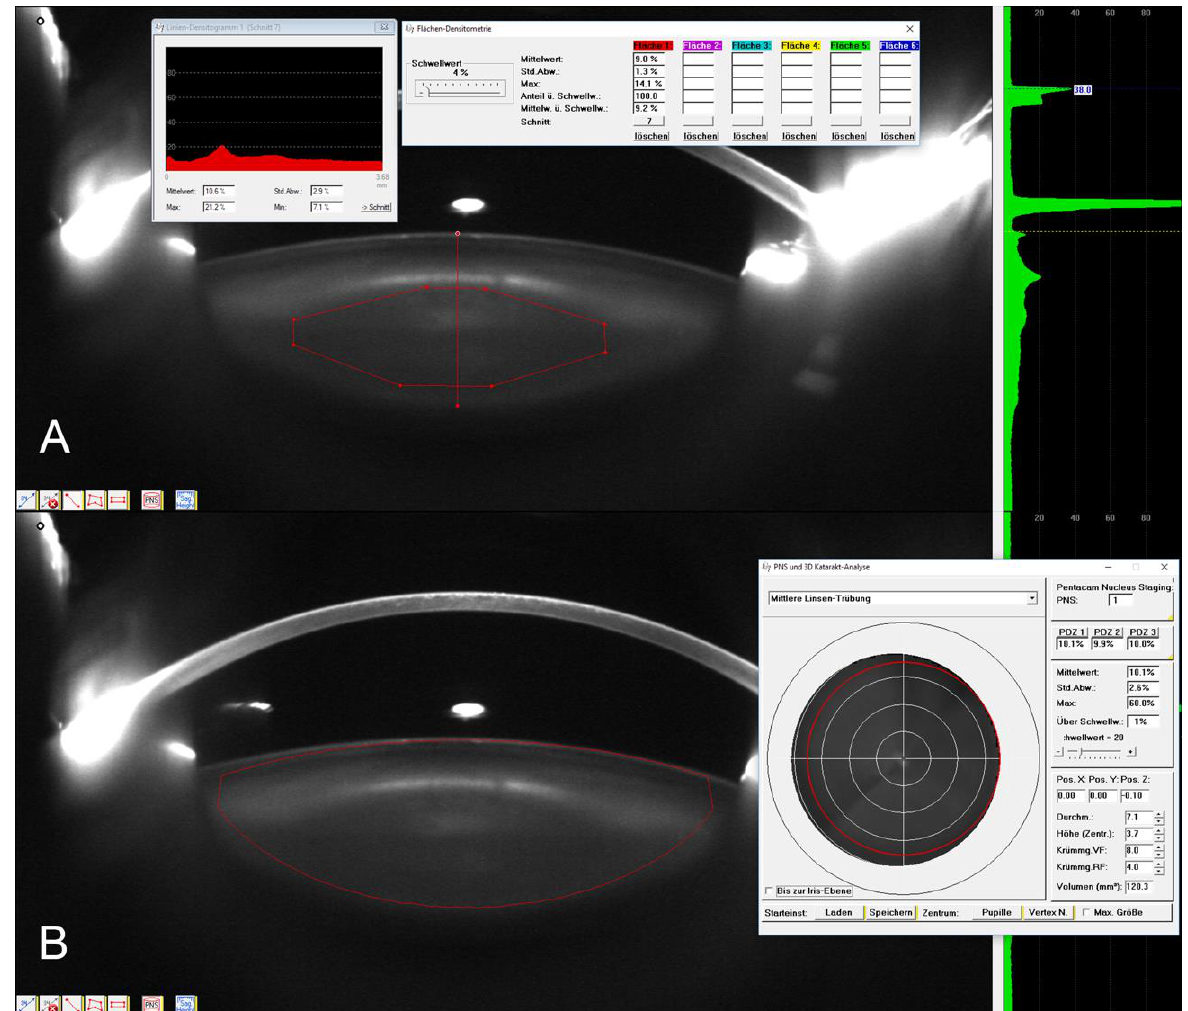
Figure 3. Manual densitometric analysis of the Pentacam images using the nucleus (ROI) ( A ), the linear method ( A ) and the lens (3D) method ( B ).